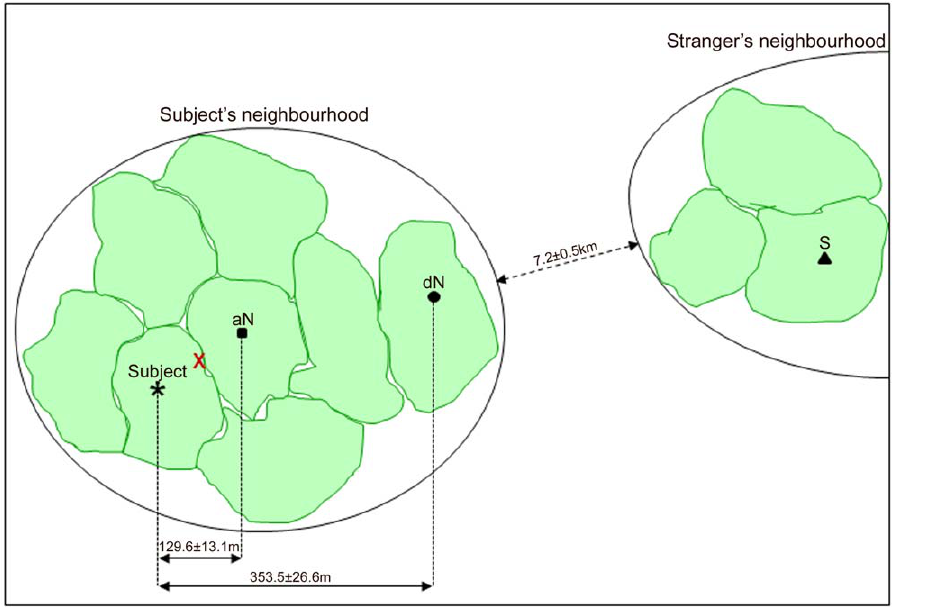
Figure 2. Playback experiment design. Schematic overview of the territories of a tested subject (*) and the adjacent Neighbour (aN, square), the distant Neighbour (dN, circle) and the Stranger (triangle) whose songs were played at the subject’s territory boundary (X). Distances between the subject’s territory and the territories of the adjacent and distant Neighbours, and between the subject’s neighbourhood and the Stranger’s neighbourhood are indicated (mean 6 SE).